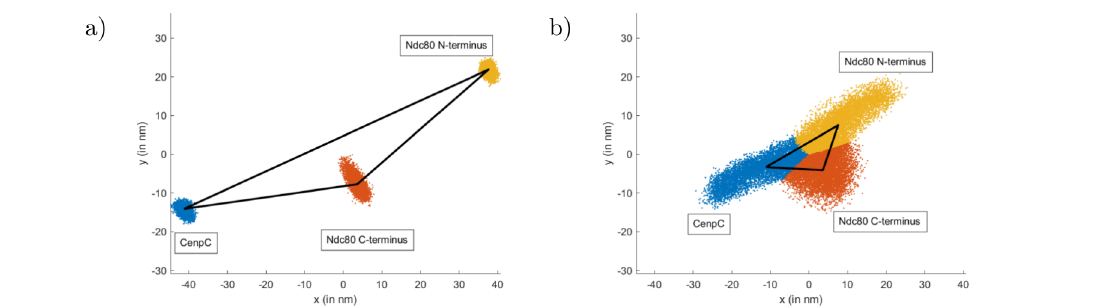
Fig 11. “Average” inferred triangle conformations of Example 4.1. The left panel is the attached state 1, the right panel the natural unattached state 2. Plots are an alternative representation of panel d) in Fig 10 and generated as Fig 9. One can see the clear conformational change between attached and naturally unattached state, whilst the latter is clearly distinct from the nocodazole state in Fig 9, panel